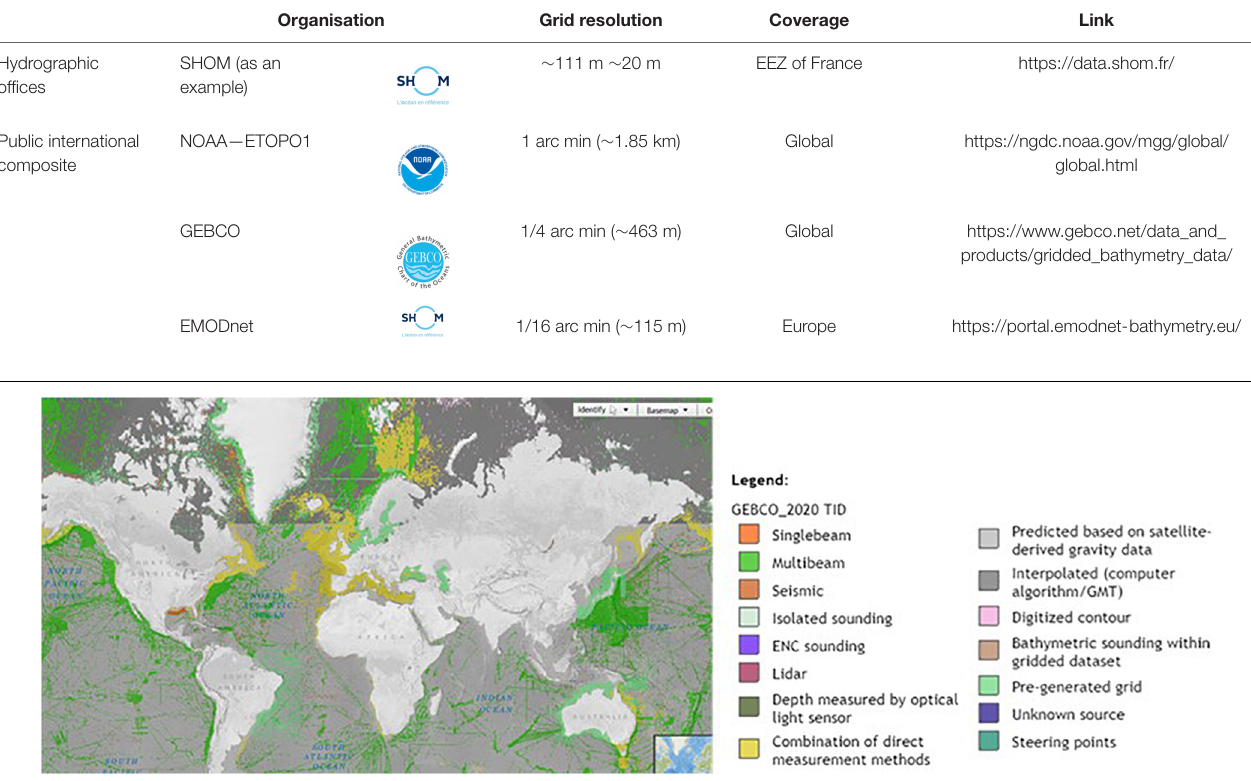
FIGURE 3 | GEBCO Type Identifier (TID) Grid showing the different type of source data used in the GEBCO_2020 gridded bathymetry.